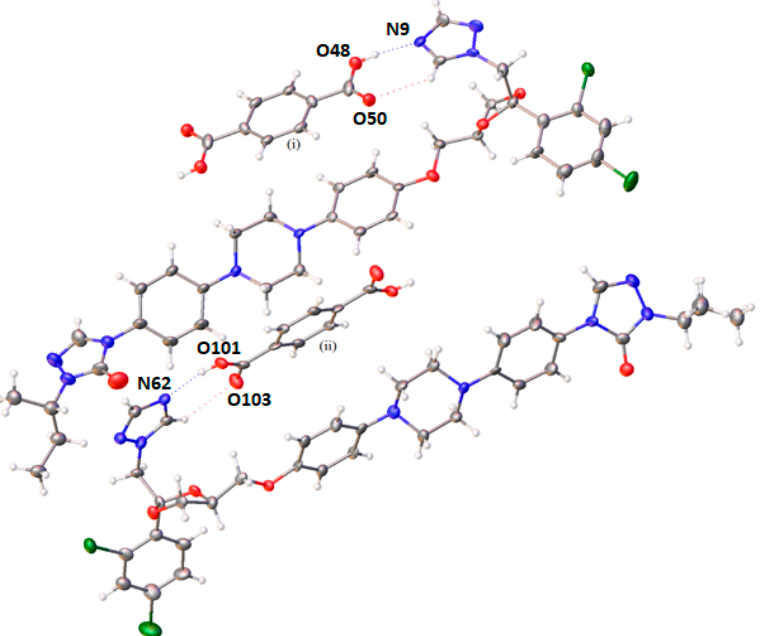
Figure 7. Crystal structure of the ITR–TER cocrystal (symmetry transformations used to generate equivalent atoms: (i) − x, 2-y, 1-z; (ii) 1-x, 1-y, 1-z) showing the major disorder in the ITR moiety only.